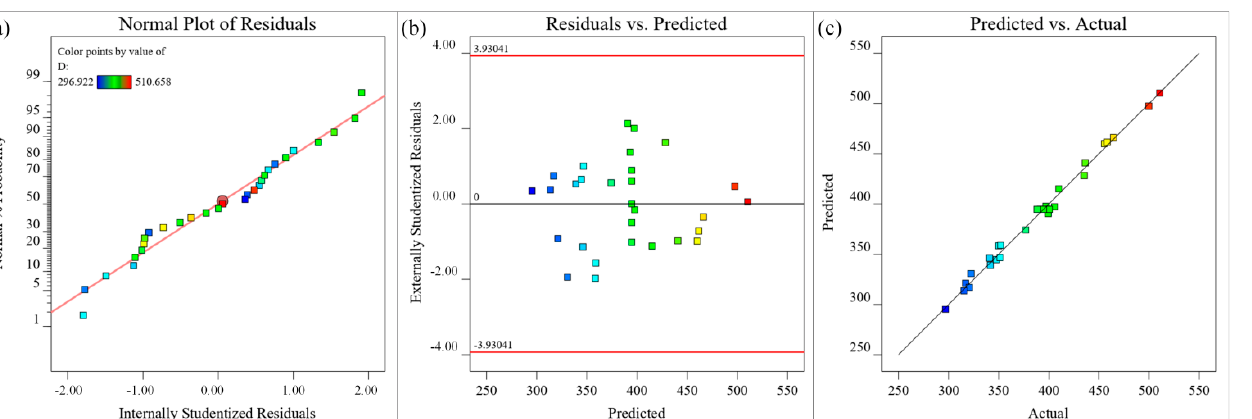
Table 9. ANOVA of the regression model for top width.